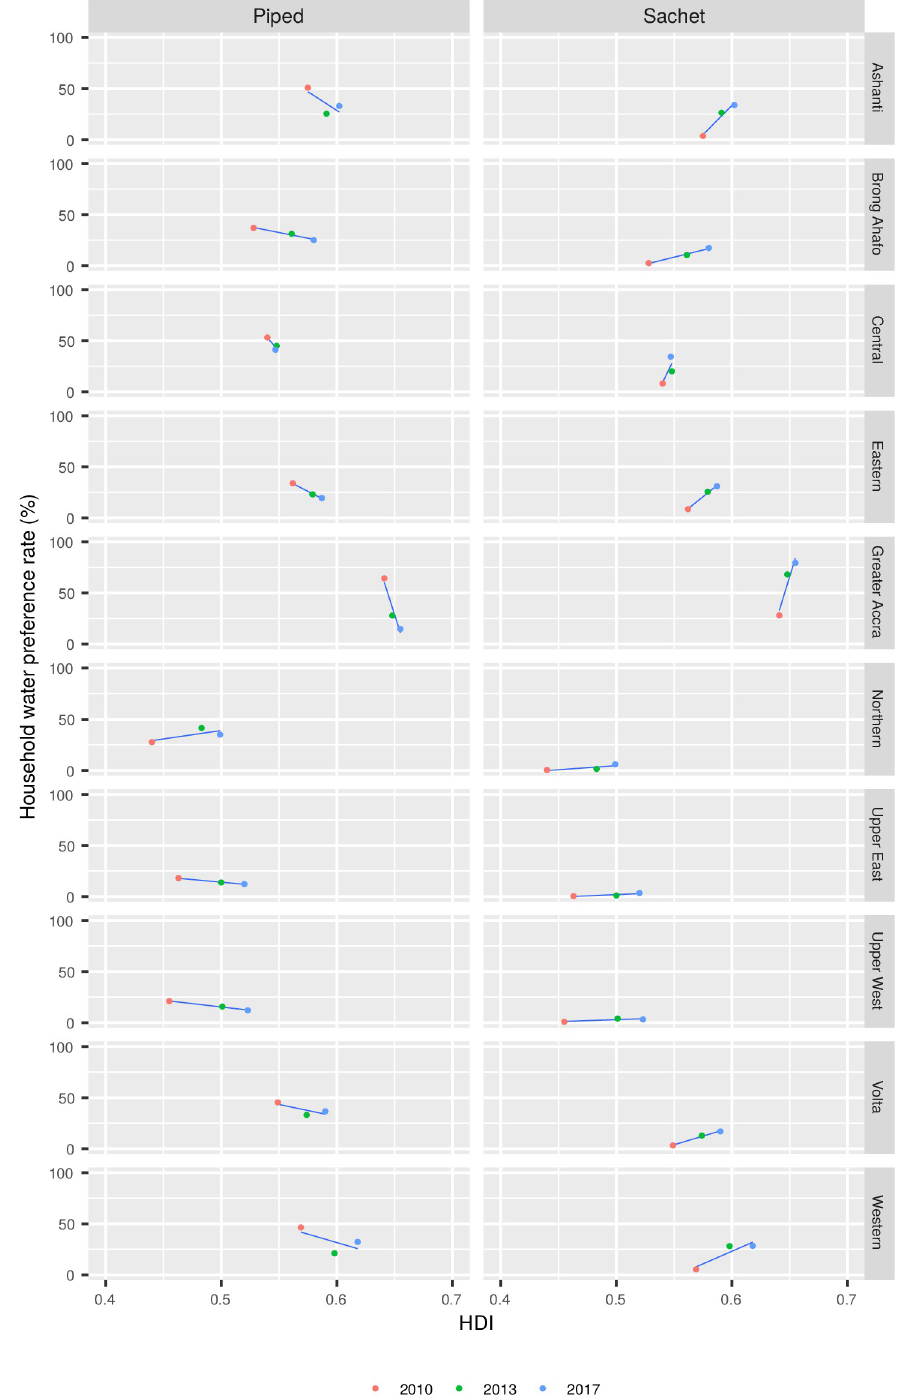
Fig 7. Correlations between the SHDI and the usage of sachet water or piped water as primary drinking water sources.